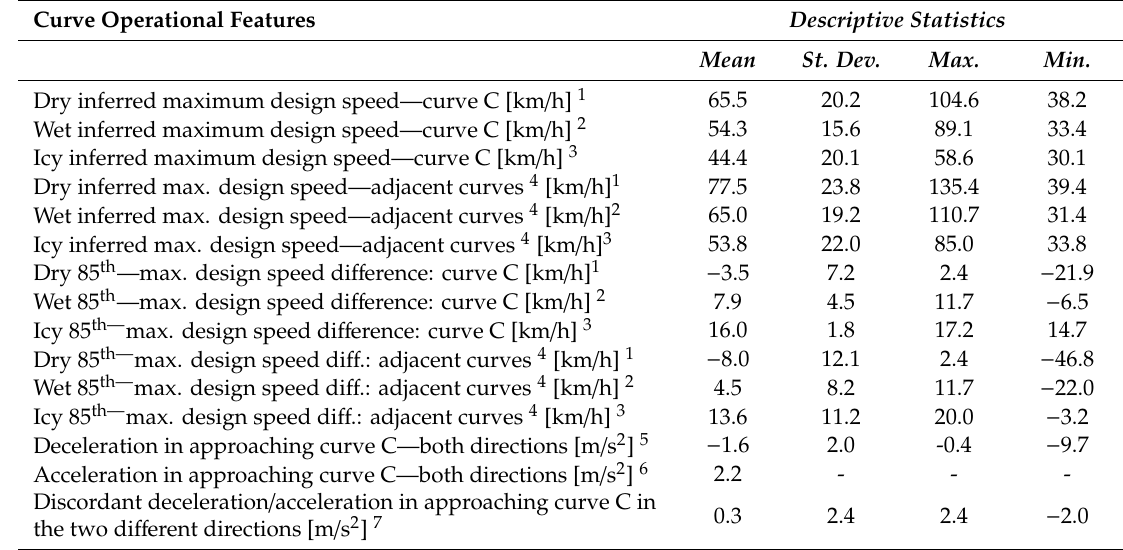
Table 3. Descriptive statistics of the operational features of ROR FI curved crash sites (each statistic was computed over the total number of curve sites that met the specific requirements